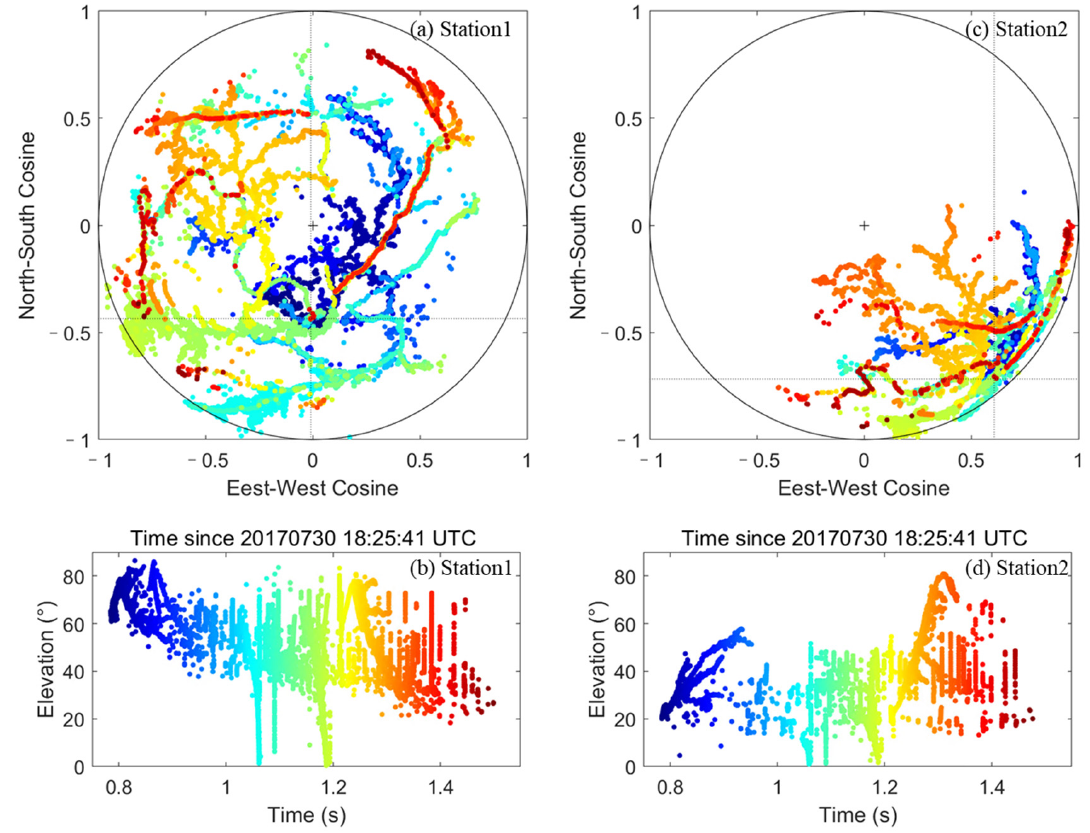
Figure 7. Two-dimensional mapping results of a cloud-to-ground lightning flash. Cosine projection ( a ) and elevation with time ( c ) observed by Station 1. ( b , d ) are the same as ( a , c ), but for Station 2. The white + shows the zenith of each interferometer, and the circle is the horizon. Dashed lines intersect at the origin of the flash.